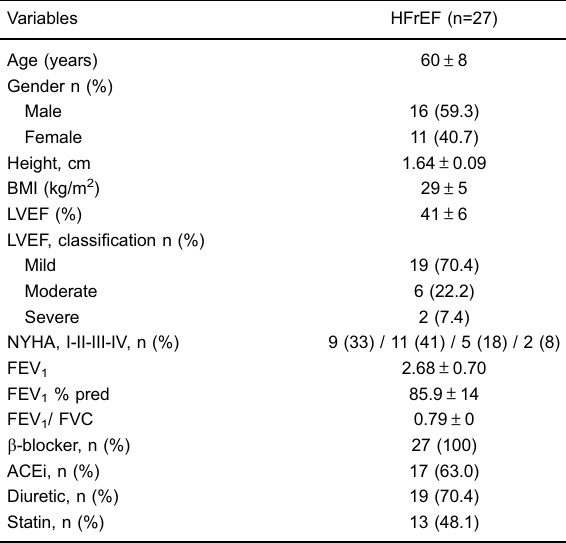
Table 1. Anthropometric characteristics, cardiac function, pul- monary function, and medication of heart failure with reduced ejection fraction (HFrEF) patients.